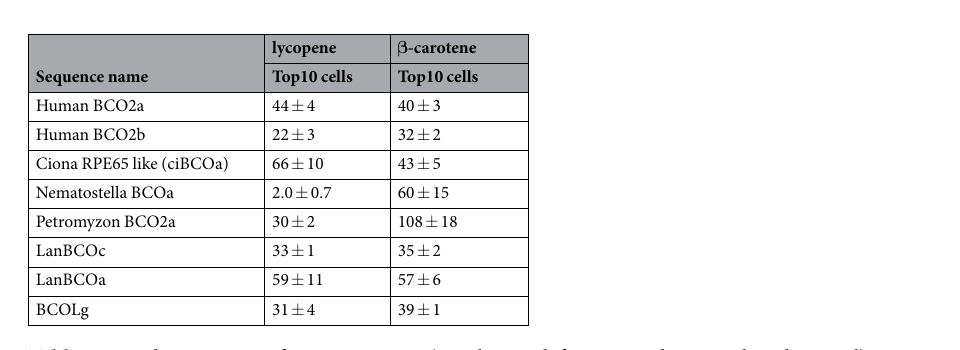
Table 2. Catalytic activity of BCO2 proteins (% substrate left compared to uninduced